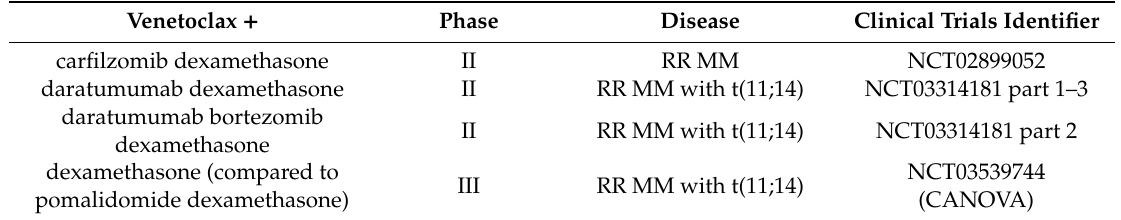
Table 3. Selected ongoing clinical trials evaluating venetoclax in combination for the treatment of MM. Venetoclax + Phase